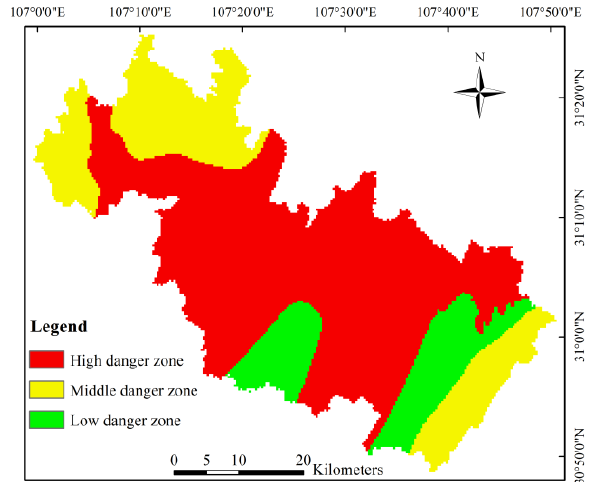
Figure 6. Potential hazard zone divided according to landforms